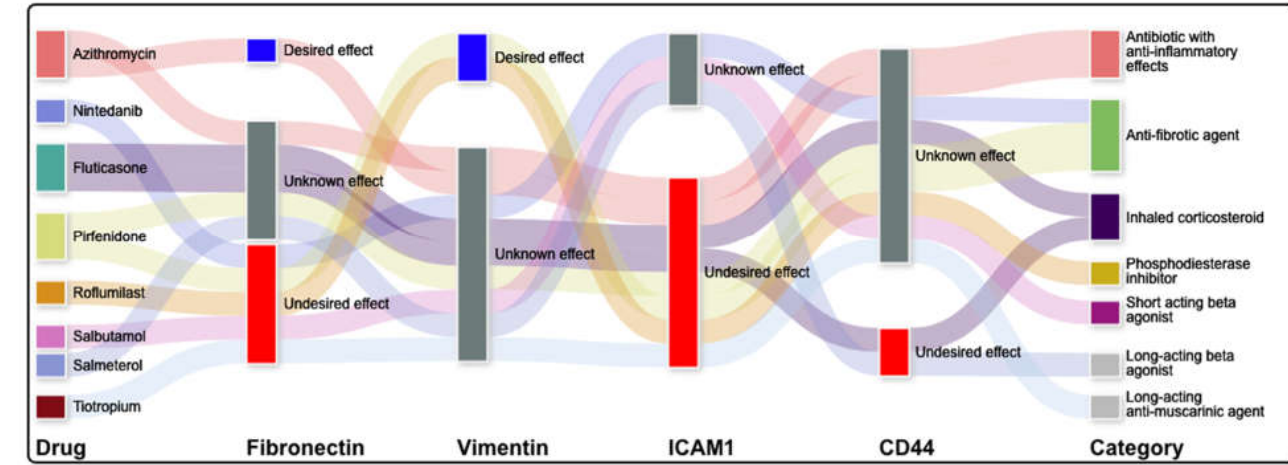
Figure 4. Commonly used pulmonary drugs and their putative effects on four central node proteins in COPD. A Sankey diagram categorizing putative drugs’ likely effects on four central node proteins in COPD is depicted. There are eight drugs on the left of the diagram used to treat different pulmonary diseases, with the corresponding drug classes displayed on the right side of the diagram. The effects of these drugs on four nodes (fibronectin, vimentin, intercellular adhesion molecule1 (ICAM1), and cd44) are detailed in the middle of the diagram, with broad lines connecting the proteins in the right to the putative effect (desired, unknown, and undesired). While some of these have been documented to have the desired effect on fibronectin (promotion) or vimentin (inhibition), all have been reported to have the opposite effect on at least one of the most central proteins. This suggests that using drugs commonly used to treat pulmonary disease, if repurposed for COPD, may have contrary effects on the mediators of the pathways involved in COPD, reinforcing the need to have a more nuanced approach to drug repurposing.